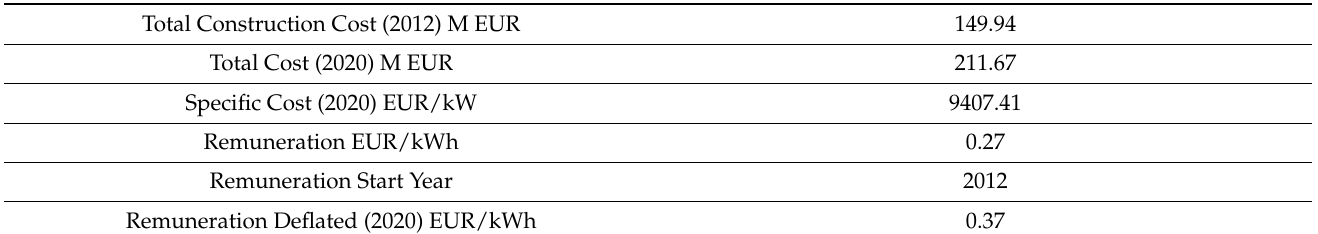
Table A3. Economic data of Solar Field